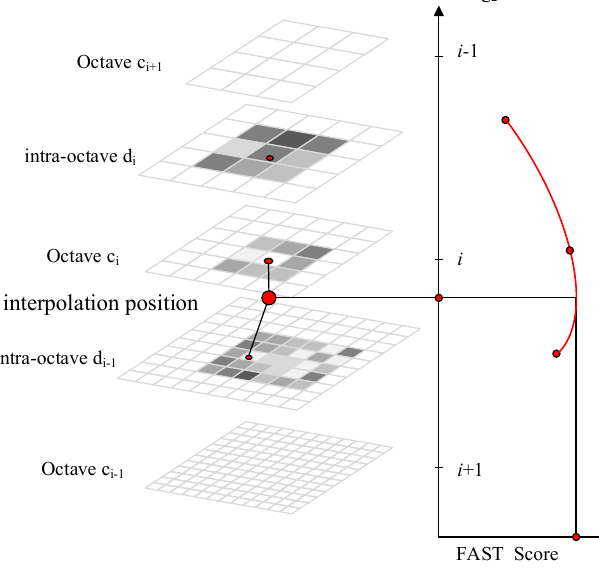
Figure 1. Scale-space interest point detection.